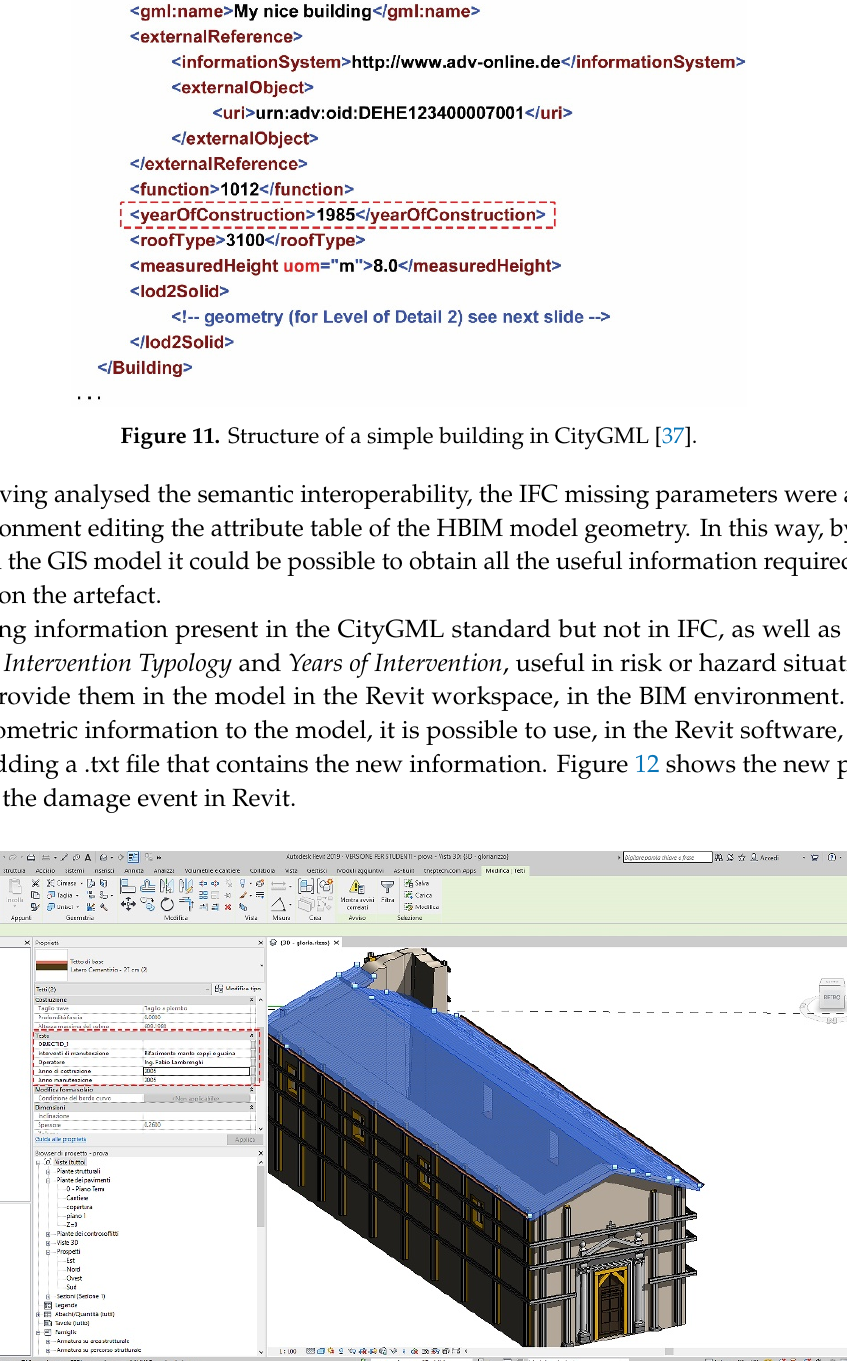
Figure 12. Population of new parameters connected to the damage event in Revit.